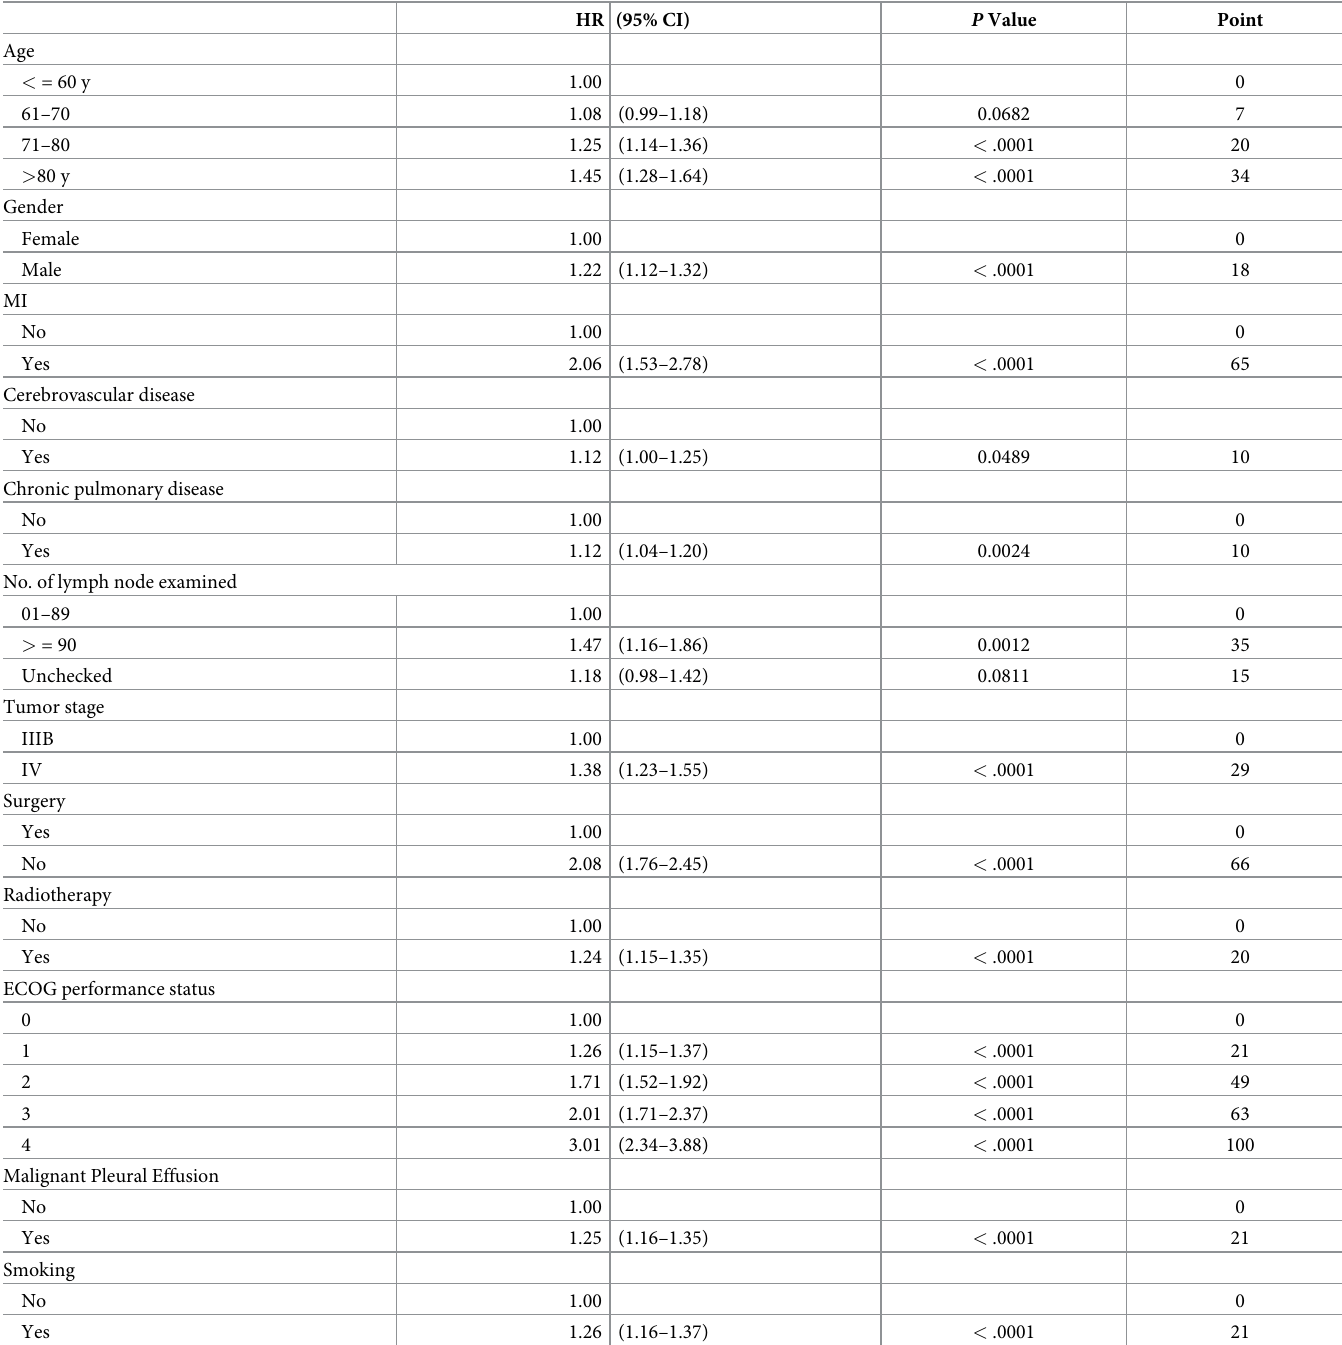
Table 3. Multivariable Cox proportional hazards regression analysis, point assignment and prognostic score: EGFR wild-type